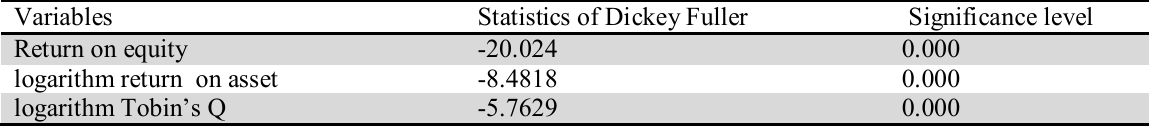
Testing the reliability of research variables Variables